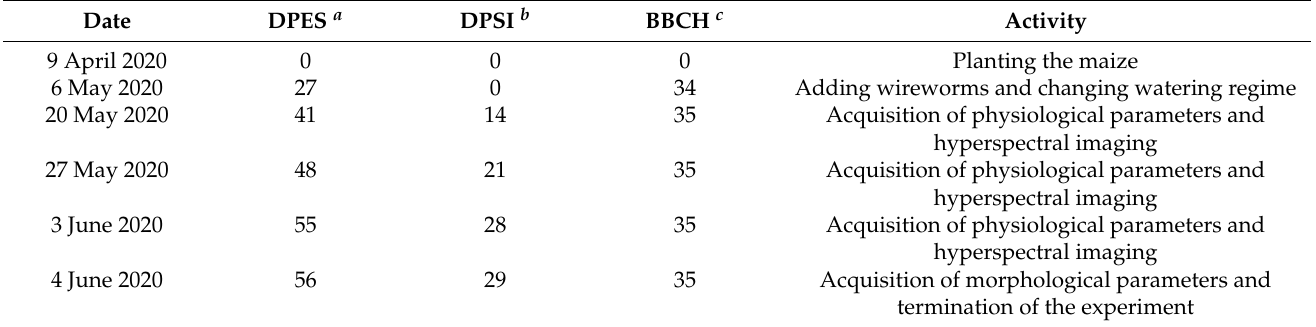
Table 2. Identification of the phenological development stages (BBCH) of maize for each experimental